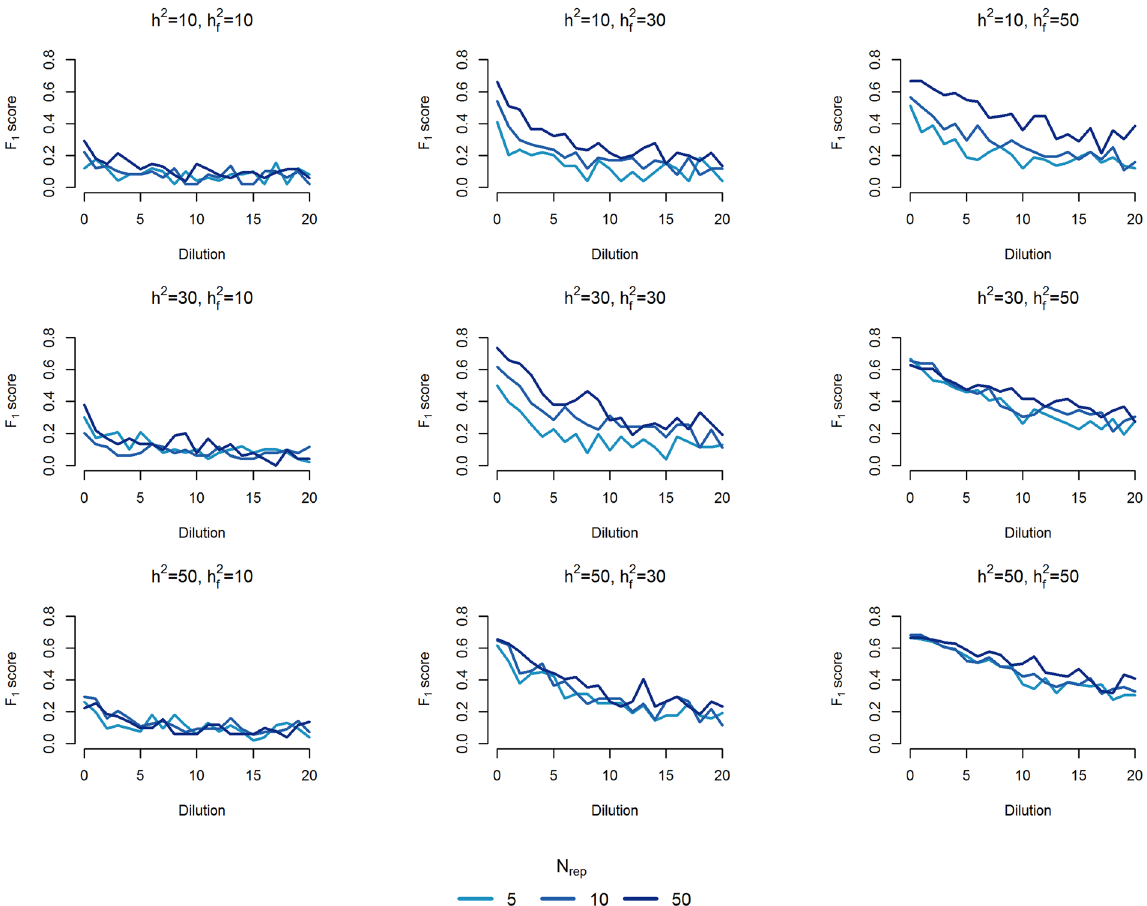
Figure 4. Influence of genomic feature, trait specific factors and dilution on detection power. In each row the heritability (h 2 ) is kept constant while the proportion of genomic variance explained by the feature increases ( h f2 = 0.1, 0.2, 0.3, 0.5). Moving down each column h 2 increases from 0.1 to 0.2 and 0.5 while h f2 is kept